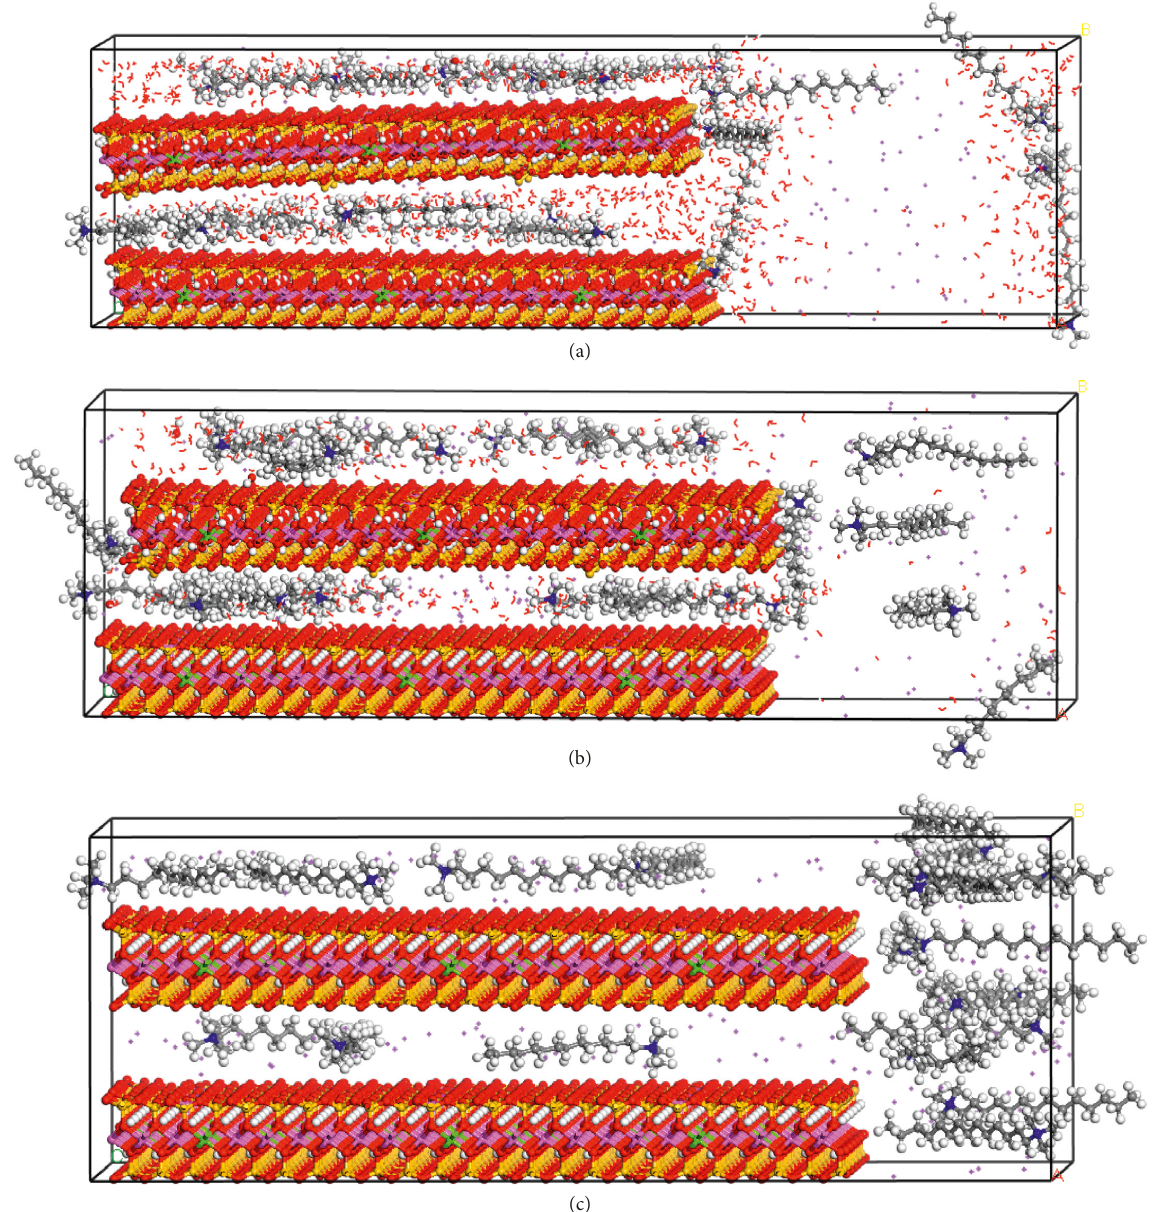
Figure 4: Molecular dynamic simulation of intercalation process. (a) 30%; (b) 10%; (c)